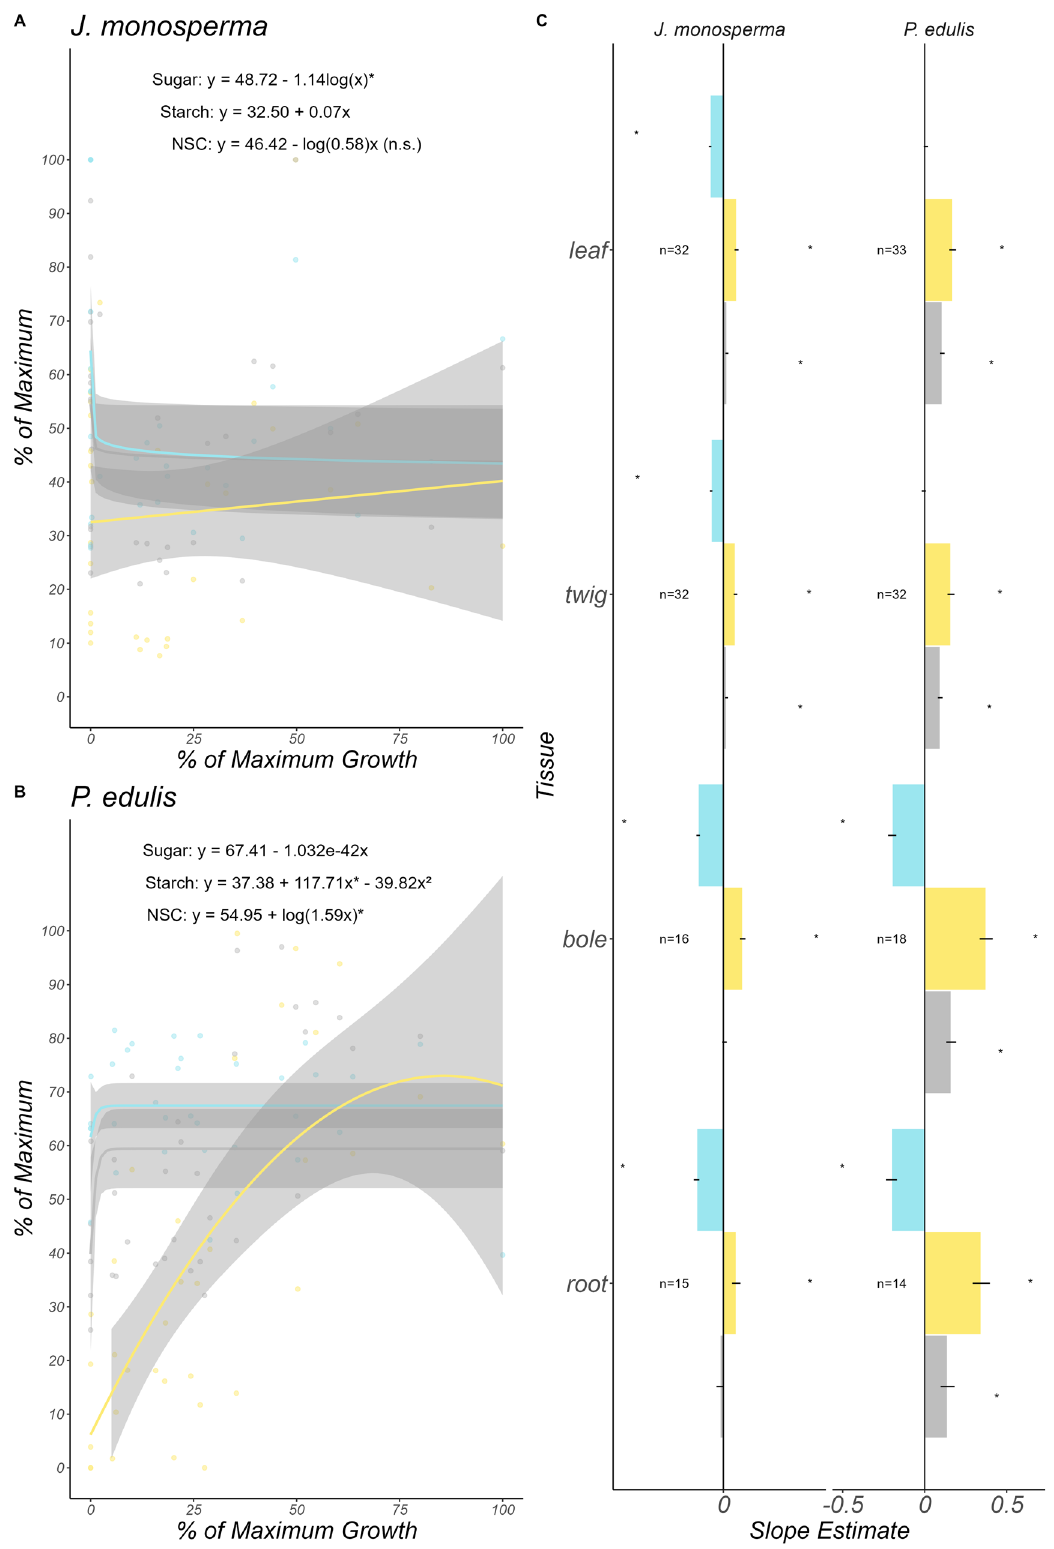
Fig.4|NSCdoesnotincreasein J.monosperma and P.edulis asgrowthdeclines. As growth becomes limited, NSC, starch, and sugar concentrations do not sig- ni fi cantly change in J. monosperma ( C ). In P. edulis , a signi fi cant decline in NSC, driven by a decline in starch, may drive the signi fi cant increase in sugar con- centrations in the bole. These tissue-speci fi c patterns are re fl ected by the unweighted averages shown in ( A , B ). Points in ( A , B ) are observations of canopy sugar (blue points and line) and starch (yellow points and line). Lines in ( A , B )